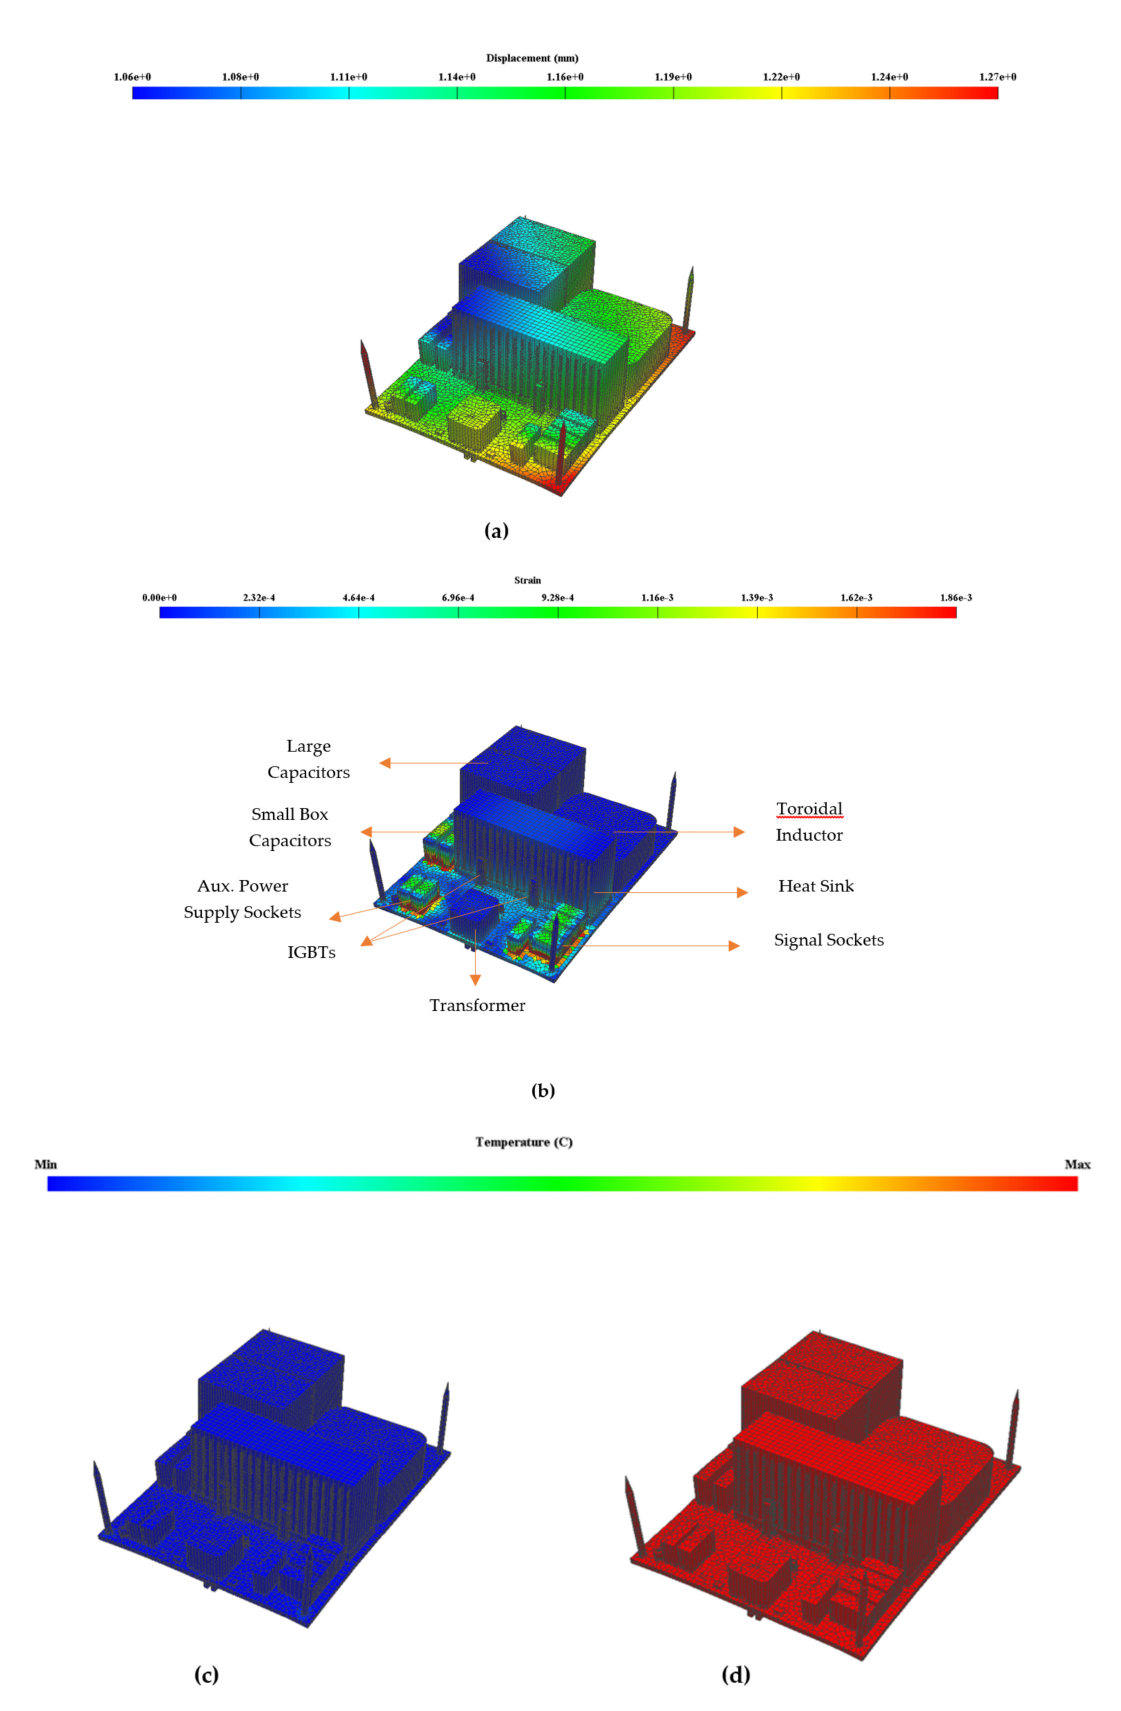
Figure 7. Thermal mechanical cycle impact on the PCB. ( a ) Different levels of displacement. ( b ) Strain on various components. ( c ) Stress at 63 ◦ C. ( d ) The impact of temperature at 63 ◦